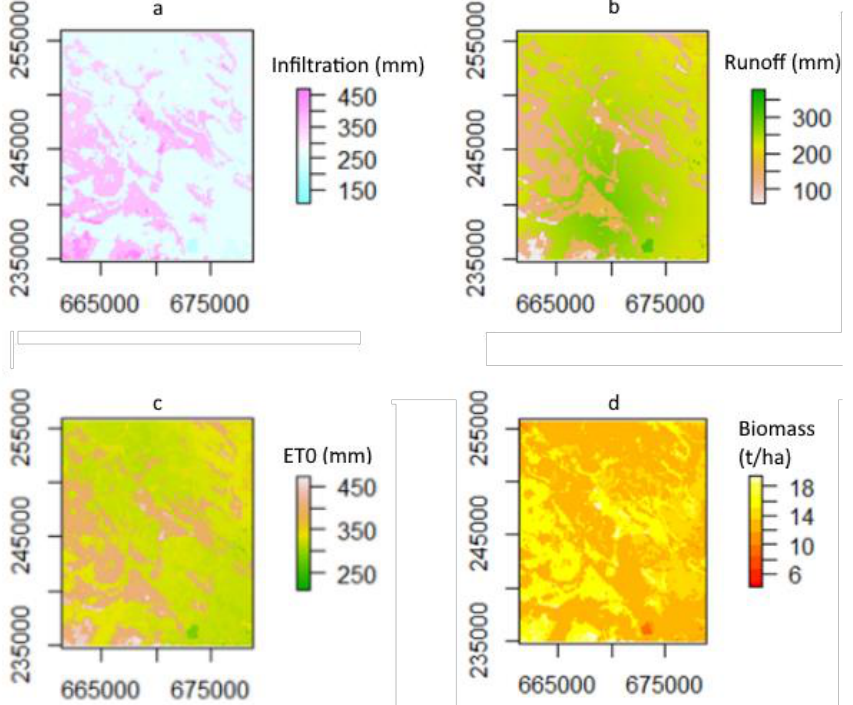
Figure 11. Spatial variation maps of seasonal infiltration ( a ), runoff ( b ), evapotranspiration ( c ), and biomass ( d ). (Projection: EPSG:23700.)